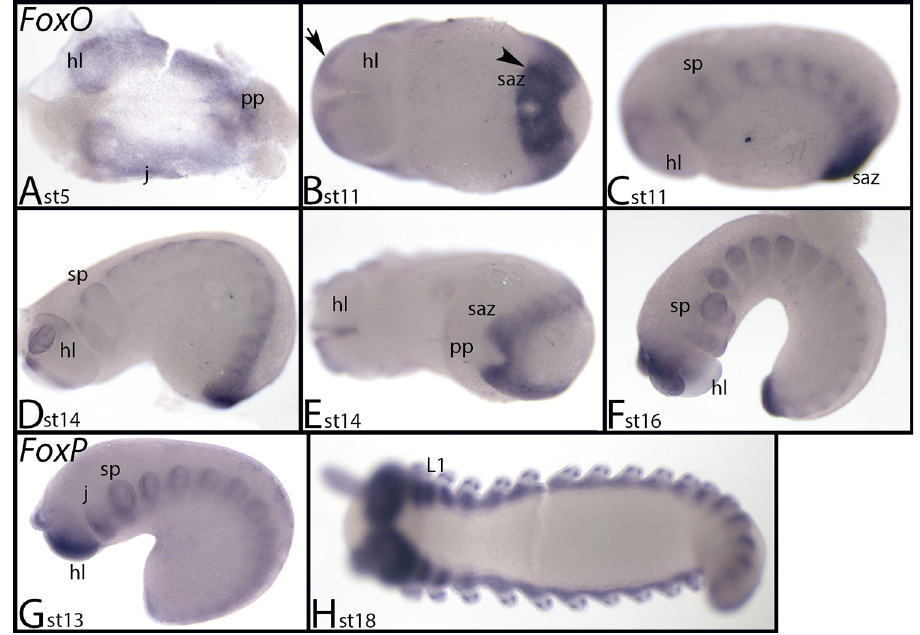
Fig 19. Expression of Euperipatoides FoxO (A-F) and FoxP (G, H). In all panels, anterior is to the left. Panels A, B, E and H show ventral views; panels C, D, F, and G show lateral views. Arrow in panel B point to expression at the anterior rim of the head lobe. Arrowhead in panel B point to a segmentation gene like ventral stripe of expression in the last formed posterior segment. Abbreviations in Table 2.